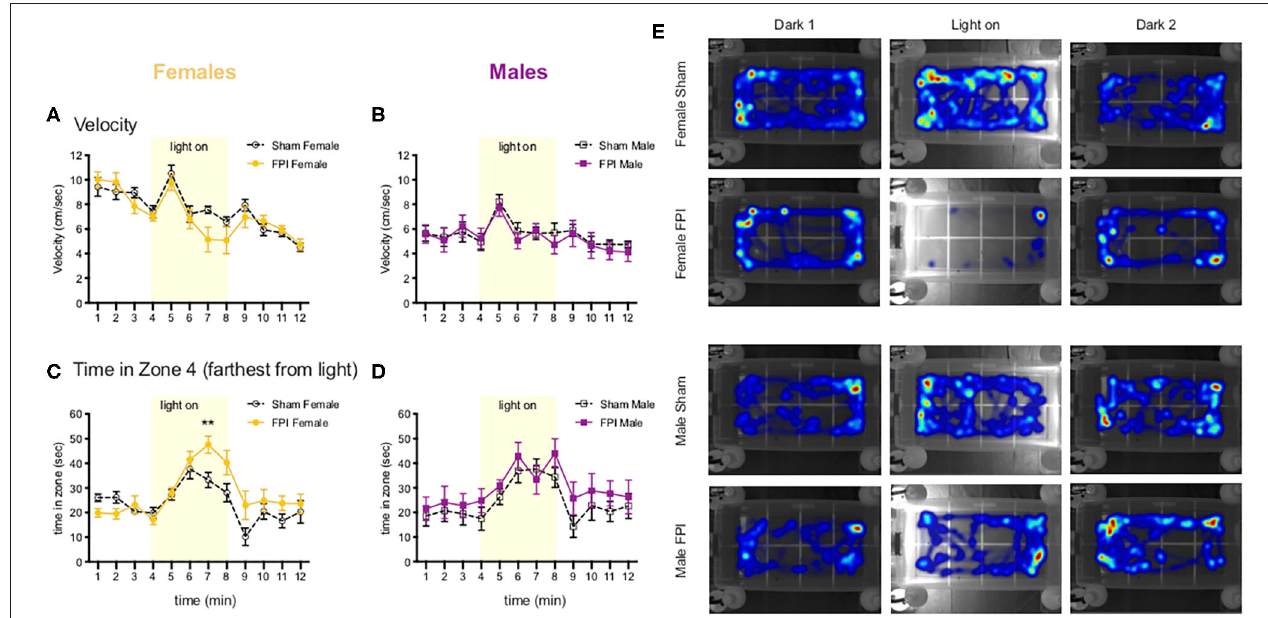
FIGURE 6 | Females show photophobia-like response in the light gradient open field after FPI (A,B) . Change in velocity across the 12min light gradient open field task. Females (A) move faster overall relative to males (B) throughout the task ( p < 0.001 Female vs. Male for velocity). Note the peak in velocity for all groups after the onset of the light stimulus (min 5) (C,D) . Time spent in zone 4 (farthest from light), FPI females spent significantly more time in zone 4 during the light on phase (** p = 0.007 Sham Female vs. FPI Female). There were no significant differences among male groups. Data are represented as mean ± SEM; n = 9–10/group. (E) Representative heatmaps for each group across the 3 phases of the task. Note light on side was counterbalanced evenly across trials for each